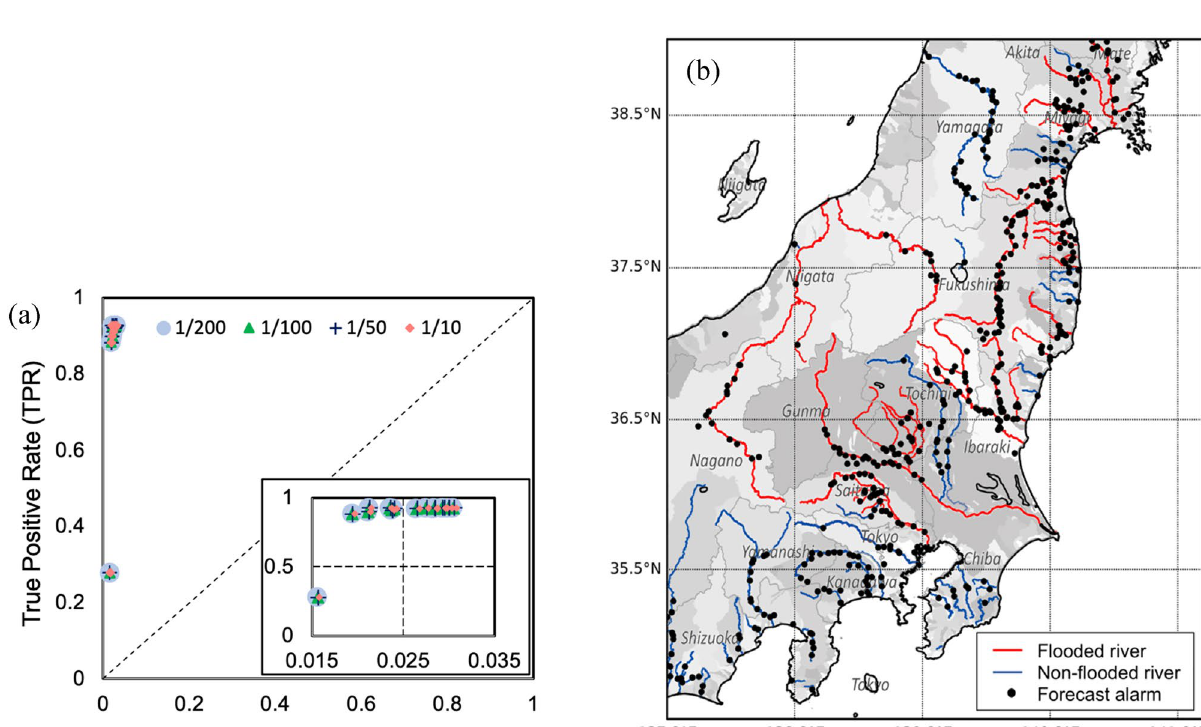
Figure 7. ROC curve for regions with precipitation in Japan ( a ) and the spatial distribution of forecast alarms and flooded major rivers due to Typhoon Hagibis ( b ). This figure was generated through Python2.7 (https:// www. python.